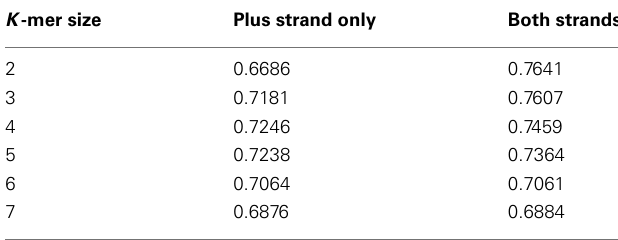
Table 2 |A sample comparison of IMEter performance with and without minus strand